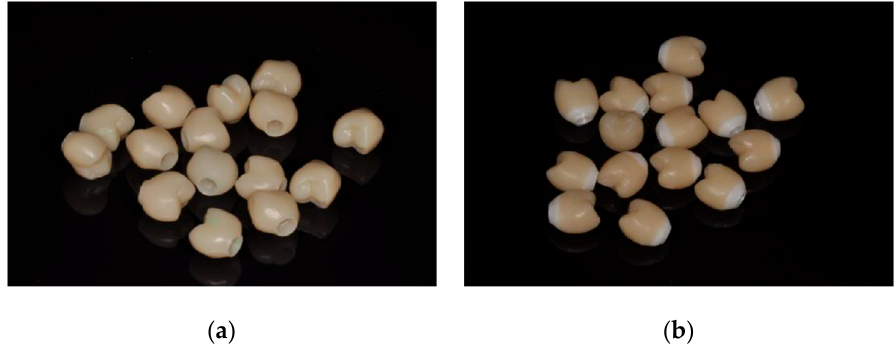
Figure 3. Crown designs: ( a ) whole nano ceramic resin crowns, ( b ) NCR crowns bonded to the customized zirconia abutment.